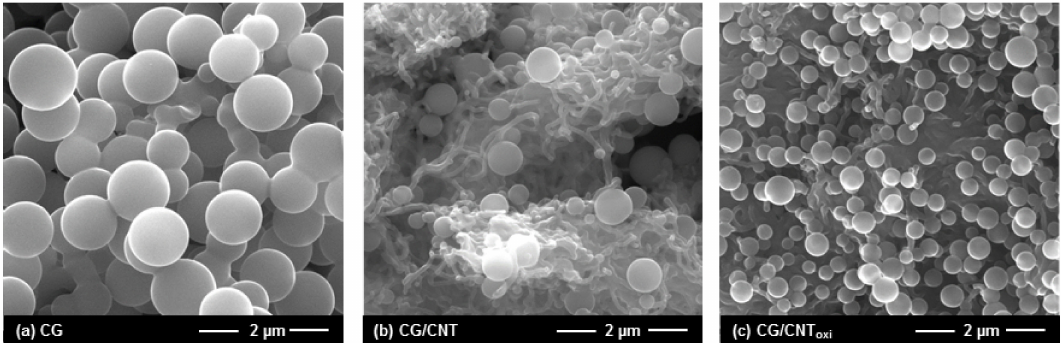
Figure 2. SEM micrographs of carbonized glucose ( a ) and carbon composites prepared by introducing CNT ( b ) and oxidized CNT ( c